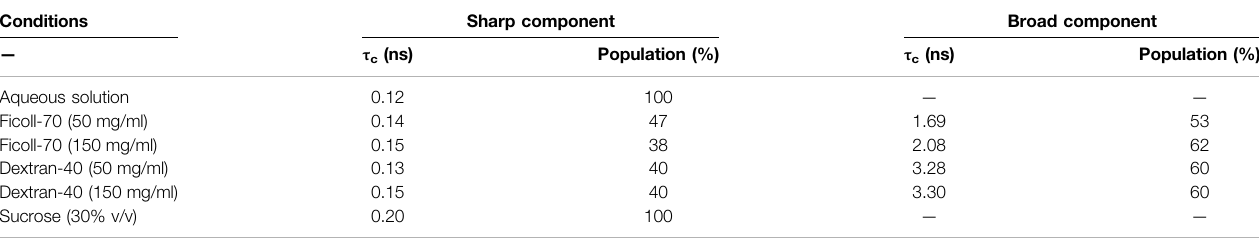
τ c (ns) Population (%)